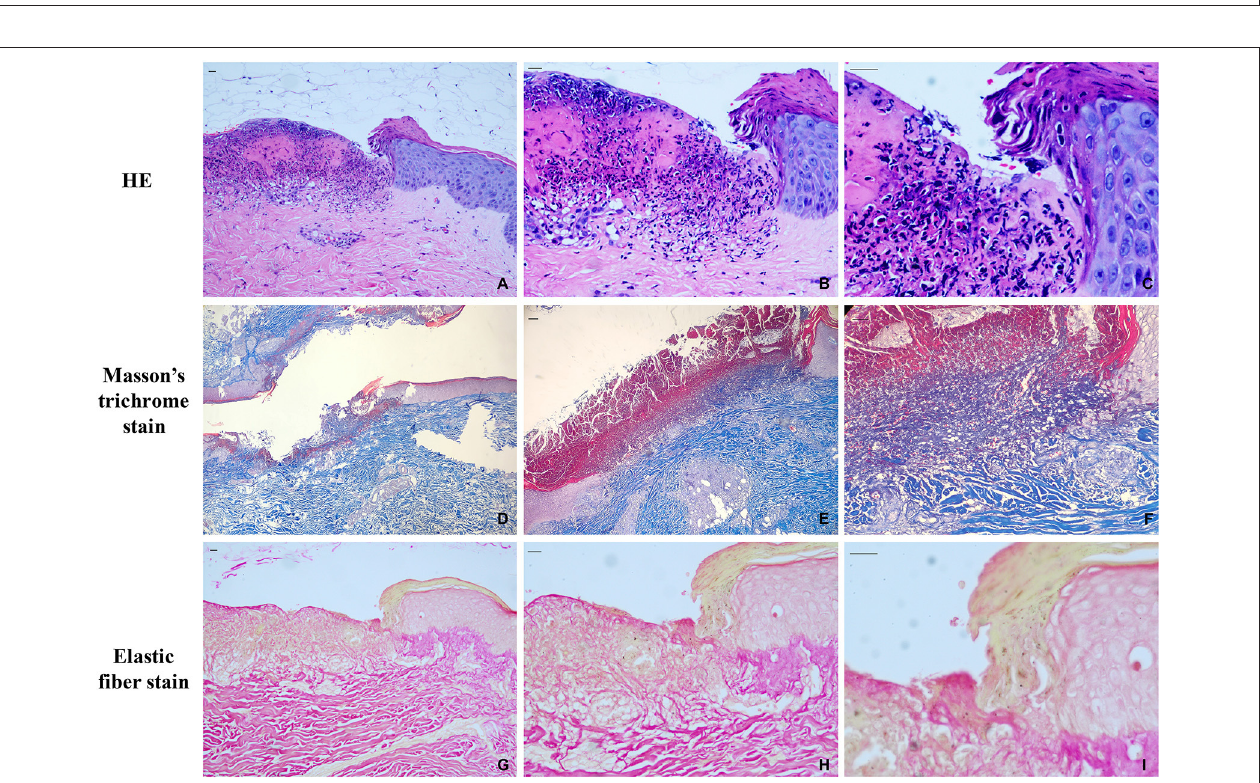
FIGURE 2 | Histopathological features at initial presentation. (A) the HE staining of APD patients (10x); (B) the HE staining of APD patients (200x); (C) the HE staining of APD patients (400x); (D) Masson trichrome staining (40x); (E) Masson trichrome staining (100x); (F) Masson trichrome staining (200x); (G) elastic fiber staining